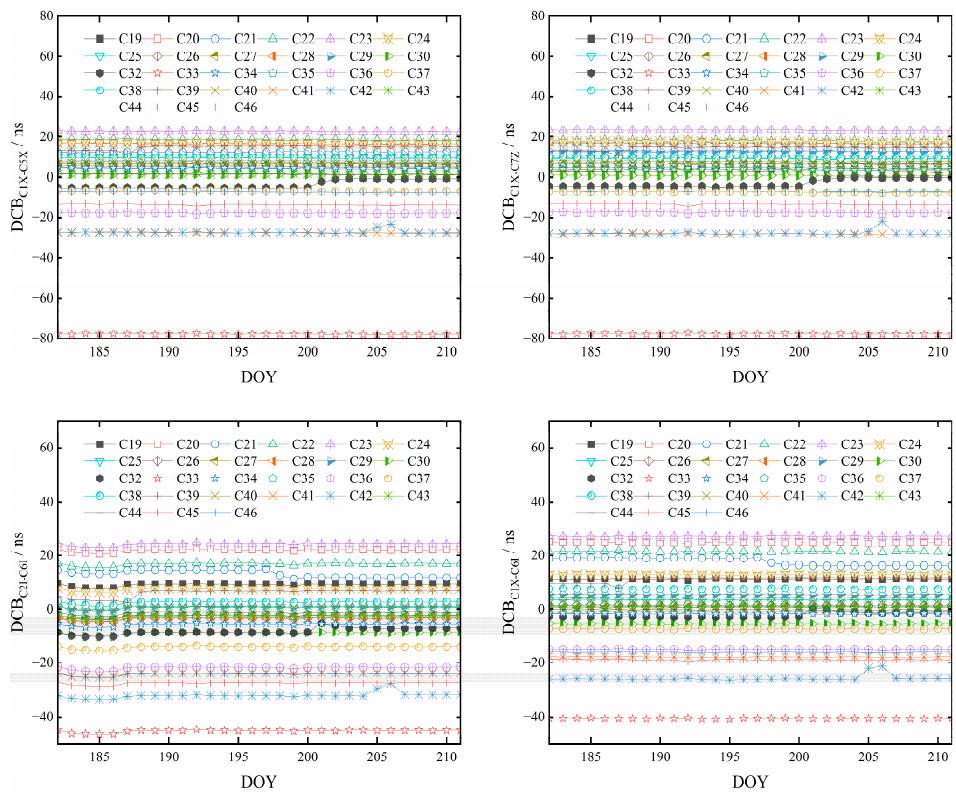
Figure 1. Time series of CAS DCB products for one month.